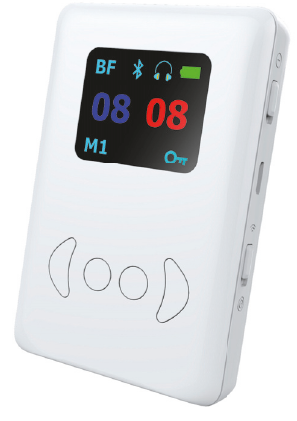
Figure 1: Front face of EasyHear Grand hearing